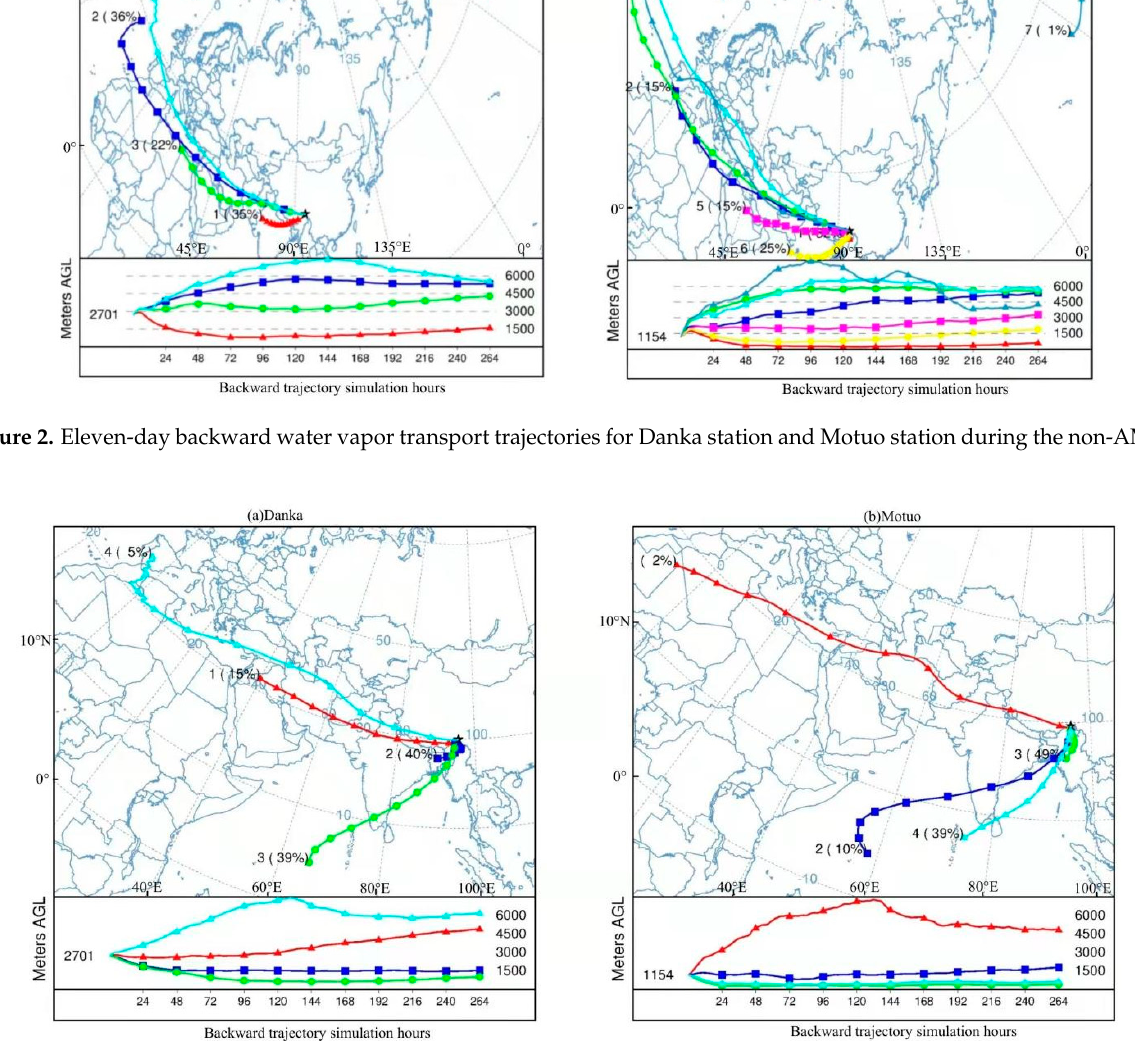
Figure 3. Eleven-day backward water vapor transport trajectories for Danka station and Motuo station during the AMS.